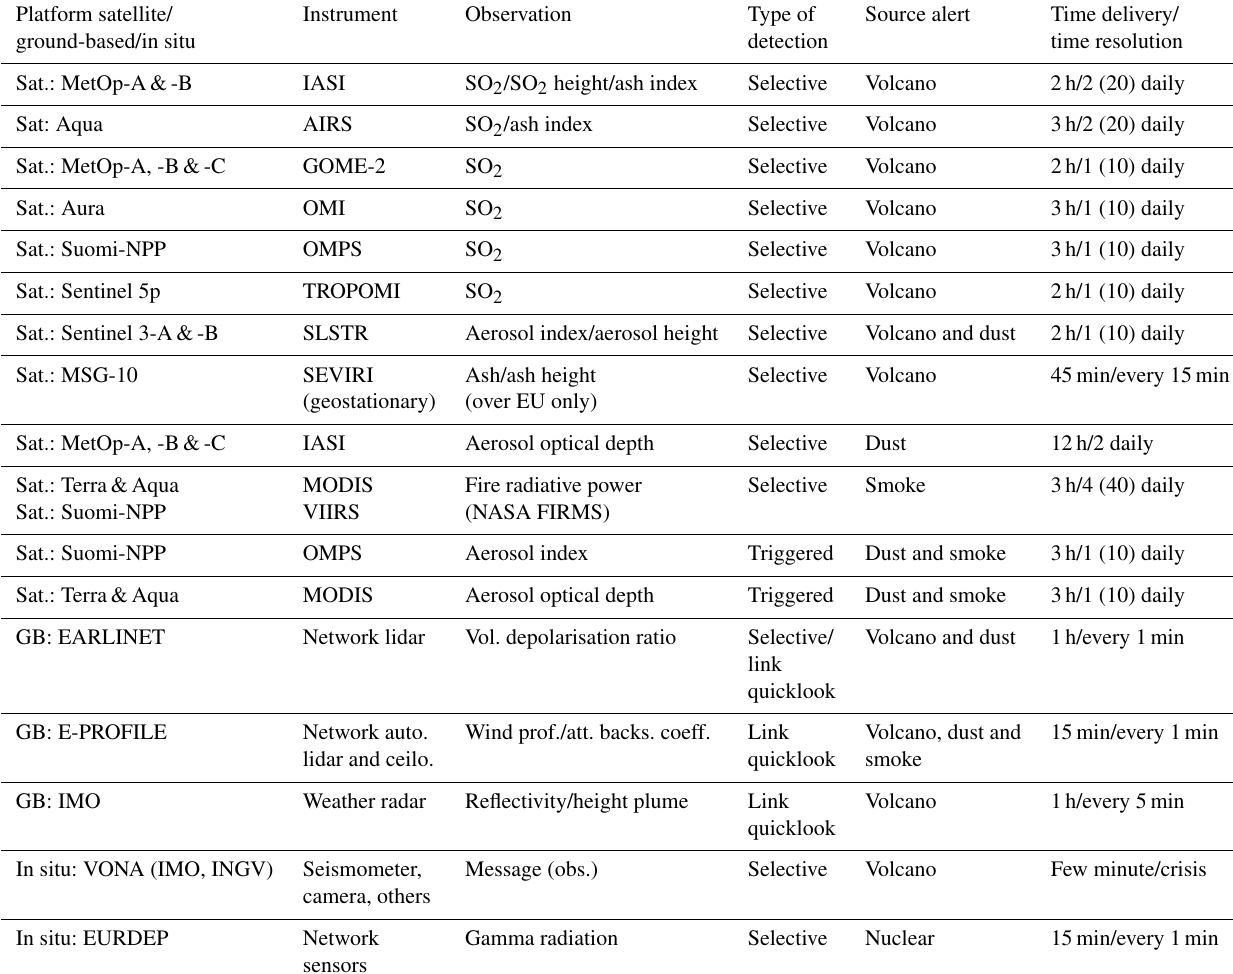
Table 6. Inventory of selective detection and alerting products (NCAP files). Platform